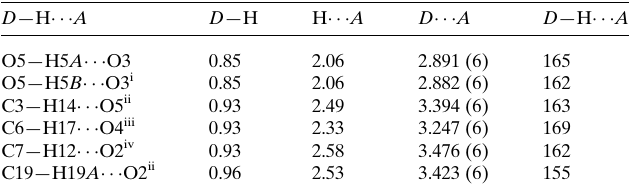
Table 1 Hydrogen-bond geometry (A˚ , (cid:4) ) for